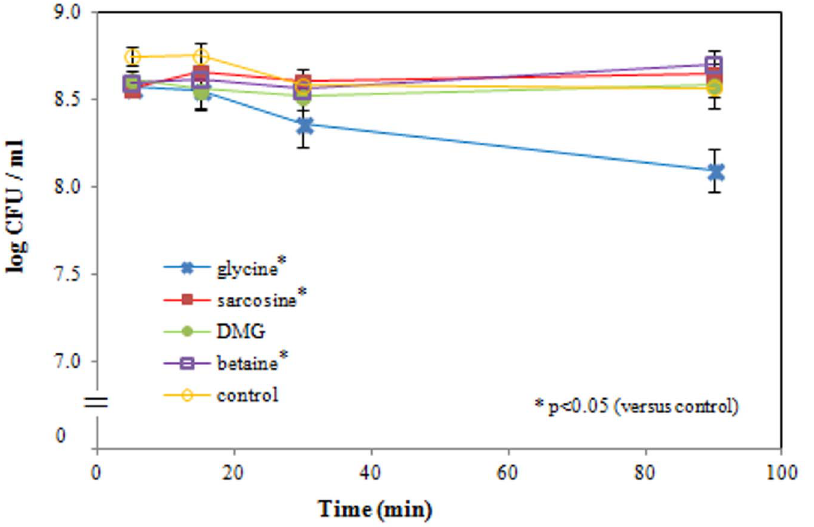
Figure 2. Culturability of E.coli . ETEC were exposed to glycine, sarcosine, DMG, betaine (50 mM, pH 9.5) and sterile PBS (control, pH 9.5) for up to 90 minutes. The slope of the time course of the glycine-, sarcosine- and DMG-exposed samples is significantly more negative than the slope of the control sample. In contrast, the slope of the betaine exposed sample is more positive compared to the control sample. Data are expressed as means 6 SD of triplicate experiments.